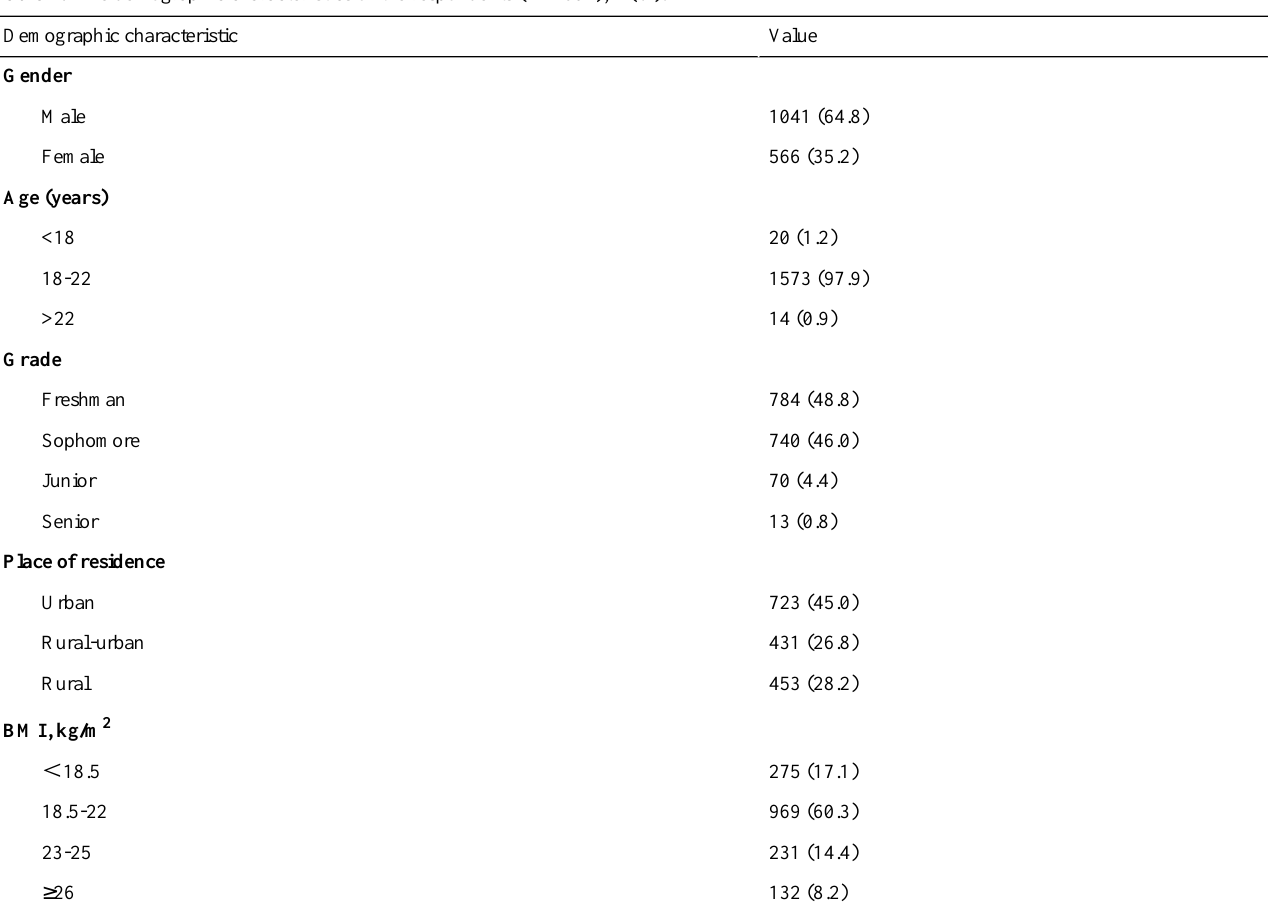
Table 1. The demographic characteristics of the respondents (N=1607), n